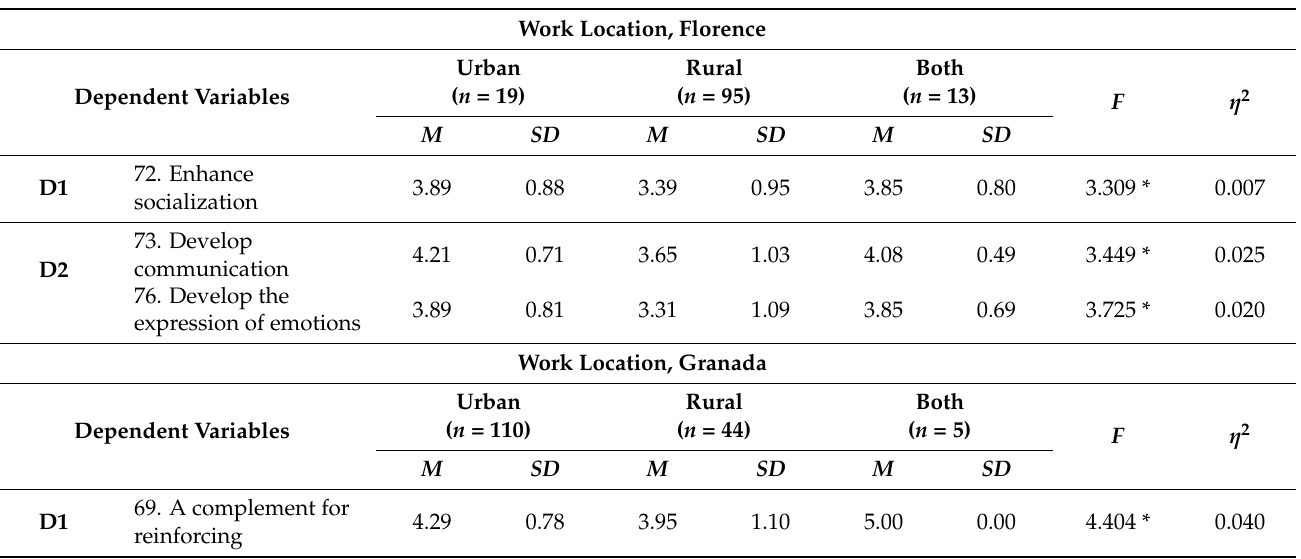
Table 12. Significant differences in the benefits and uses of apps as a function of the work location of teachers from Florence and Granada.